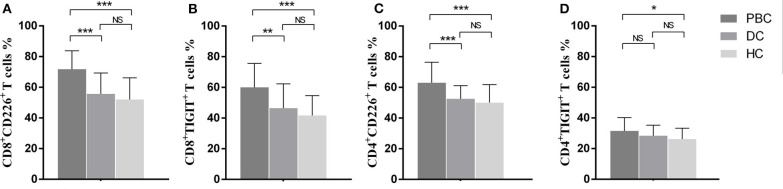
Frequencies of CD226- and TIGIT-positivity in peripheral T cells from PBC patients, disease controls, and healthy controls. Proportional comparison of the peripheral CD8+CD226+ T cells (A), CD8+TIGIT+ T cells (B), CD4+CD226+ T cells (C), and CD4+TIGIT+ T cells (D) among groups. The data of each group are presented as the means ± standard deviations. *p < 0.05; **p < 0.01; ***p < 0.001.